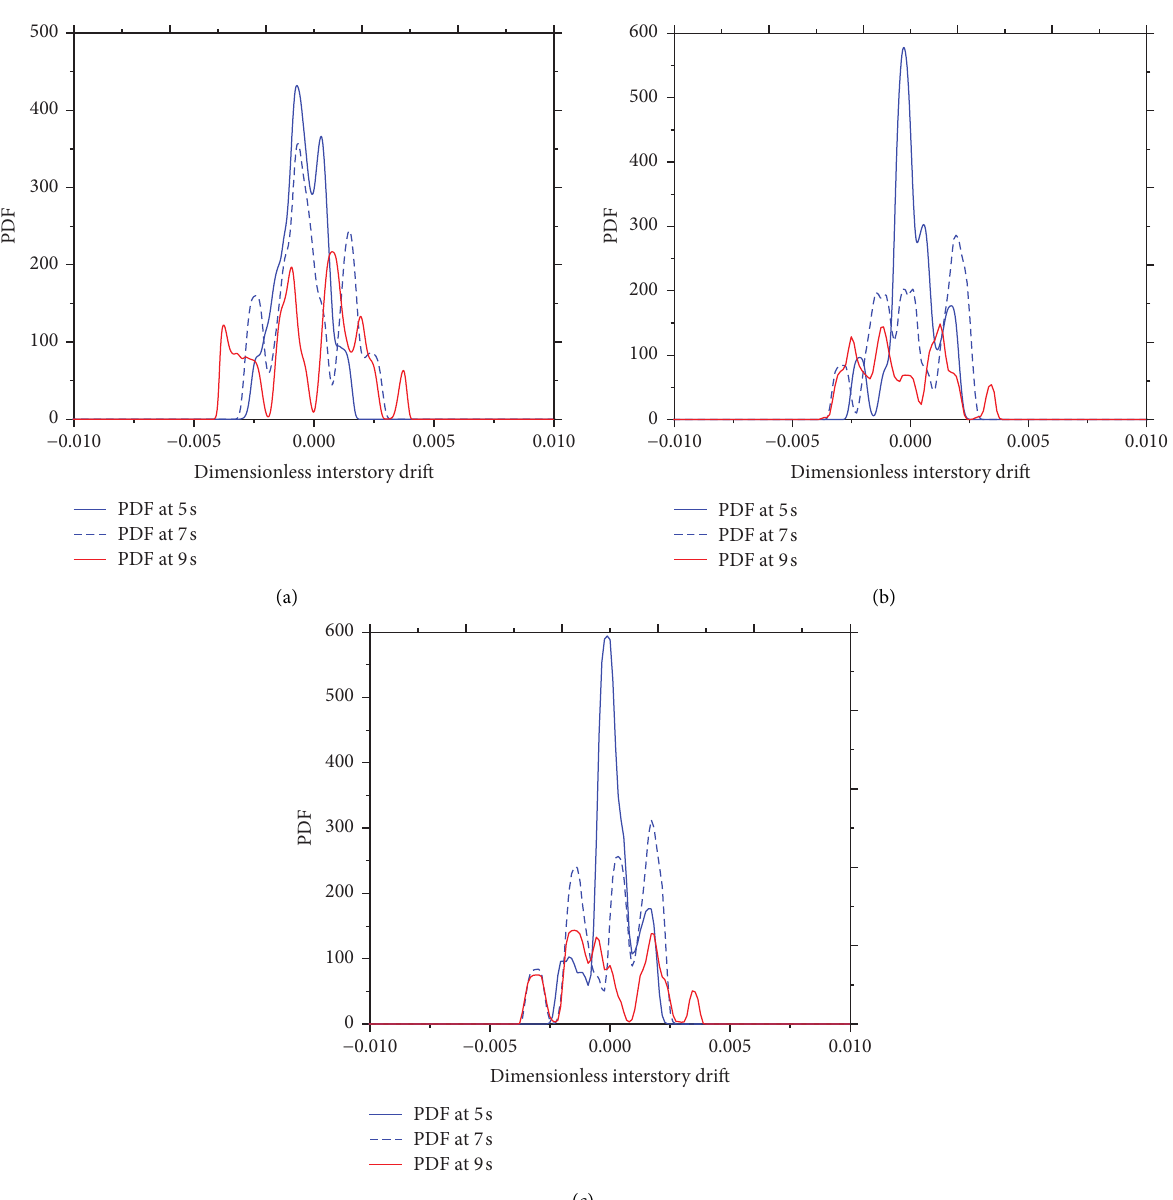
Figure 10: The PDFs of the dimensionless interstory drift for the 10-story building at typical time instants. (a) X direction, (b) XY direction, and (c) XYZ